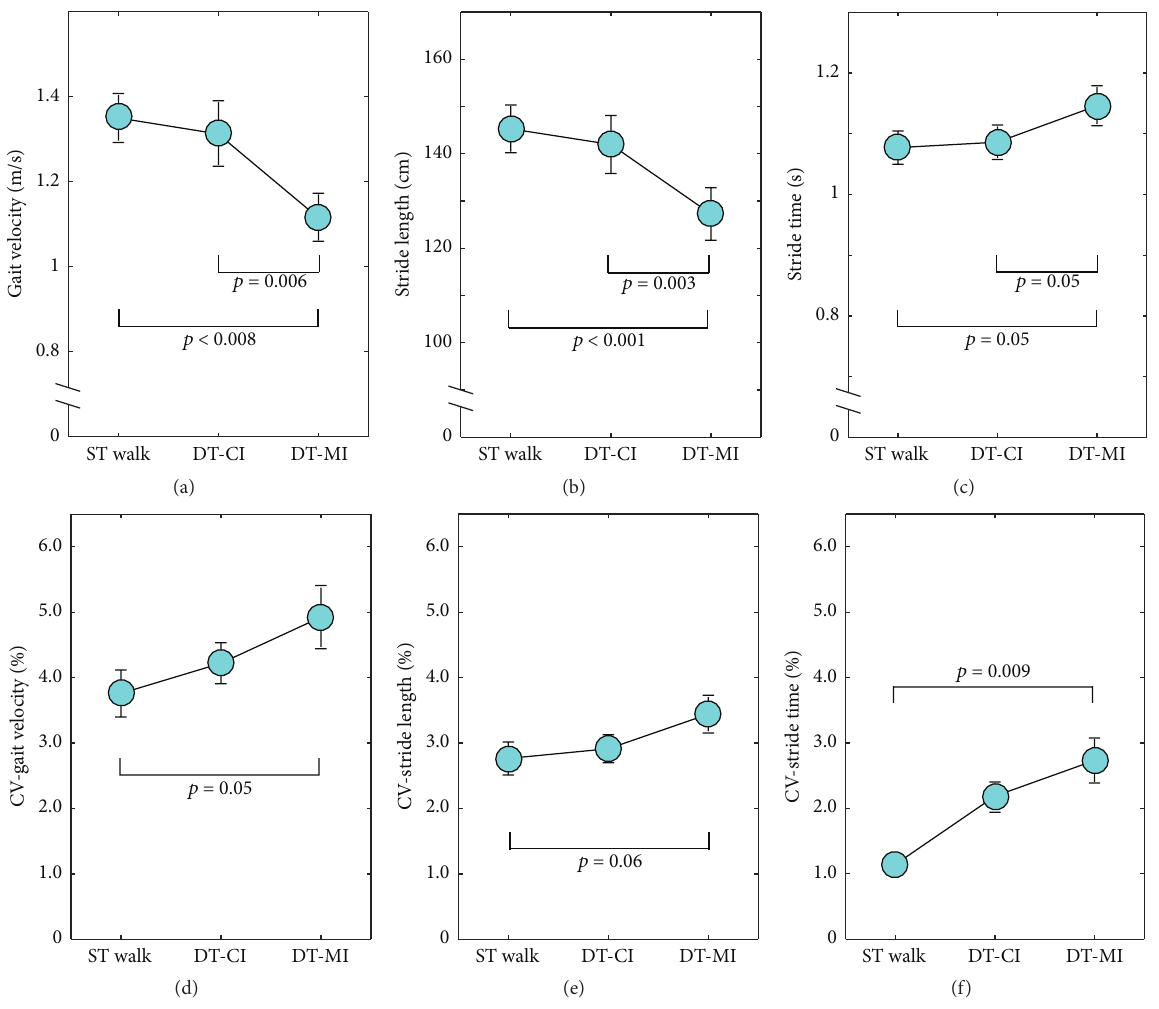
Figure 1: Subjects’ mean gait performance and the respective variability measures, separated by condition (ST walk: single-task walking, DT-CI: walking + cognitive interference, DT-MI: walking + motor interference) for (a) gait velocity, (b) stride length, (c) stride time, (d) CV-gait velocity, (e) CV-stride length, and (f) CV-stride time. Circles represent mean values and error bars the respective 95% confidence